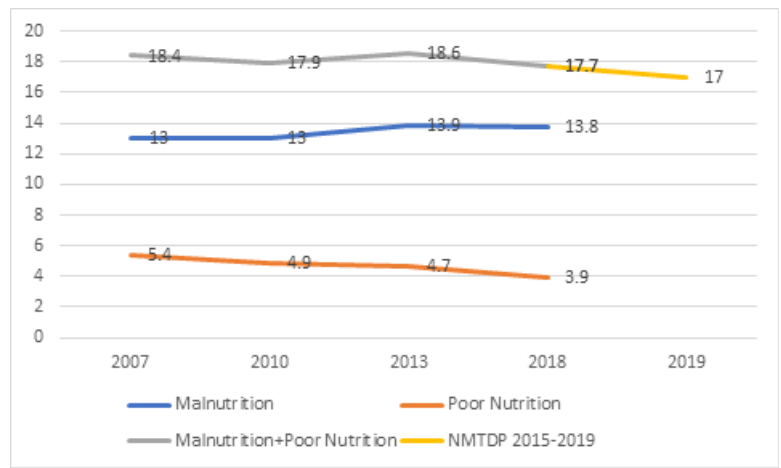
Figure 1: The proportion of Children with Nutrition Problems